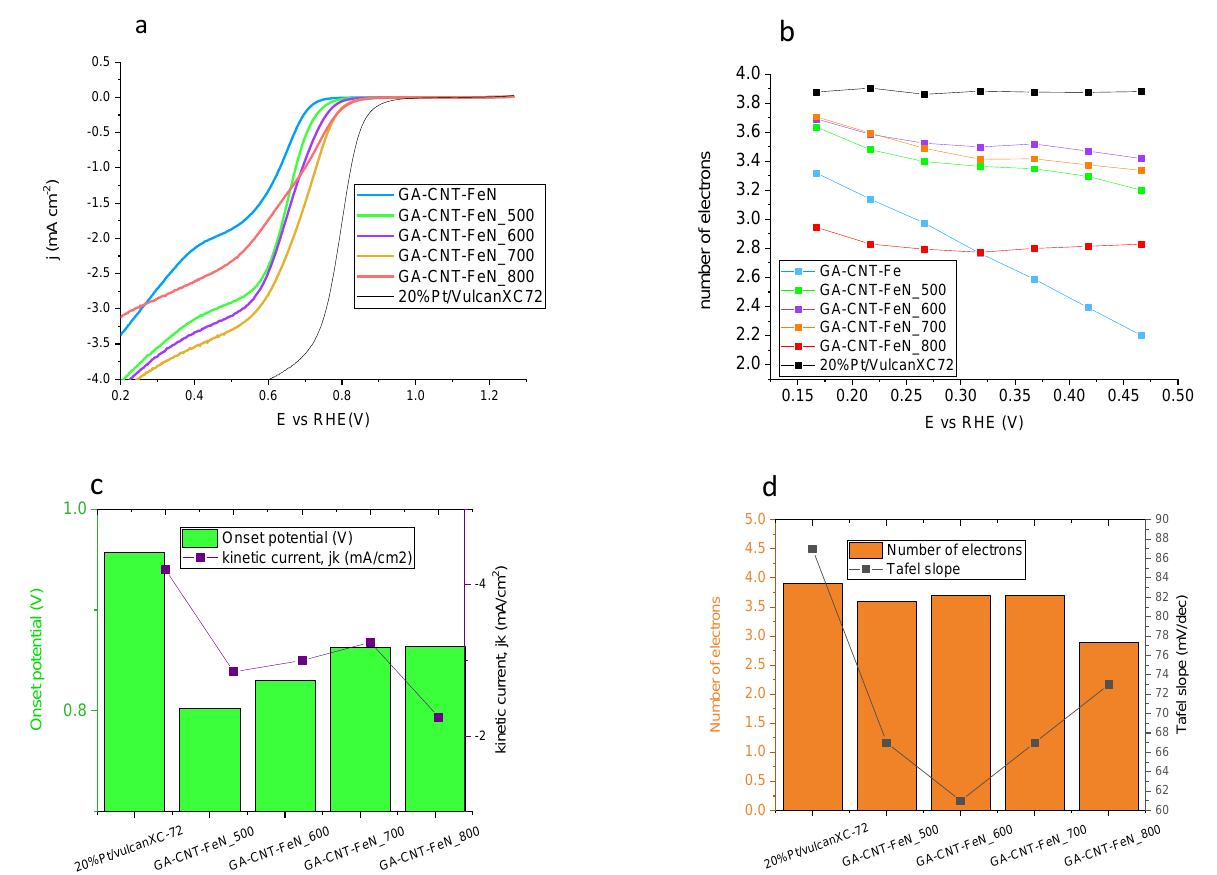
Figure 6. Polarization curves in O 2 saturated 0.10 M KOH solution with a rotating rate of 1600 rpm. ( a ) Number of electrons ( b ) and other parameters derived from the treatment of polarization curves ( c , d ) for Fe-containing GA-CNT pyrolysed at different temperatures and a commercial 20% Pt/VulcanXC72.